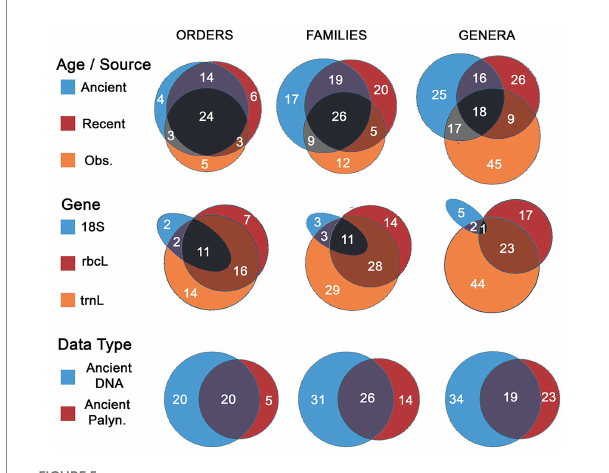
FIGURE 5 Venn diagram comparing (row 1) counts of plants taxa observed (Obs.) in previous studies of kākāpō (since 1950), and data in our study from the two main age groups (ancient and recent); (row 2) comparing counts of plants taxa observed between the three different genes used in this study (no taxa were observed found only in 18S and rbcL); (row 3) comparing counts of plants taxa observed between DNA (ancient samples only) and palynomorphs (only counted for ancient